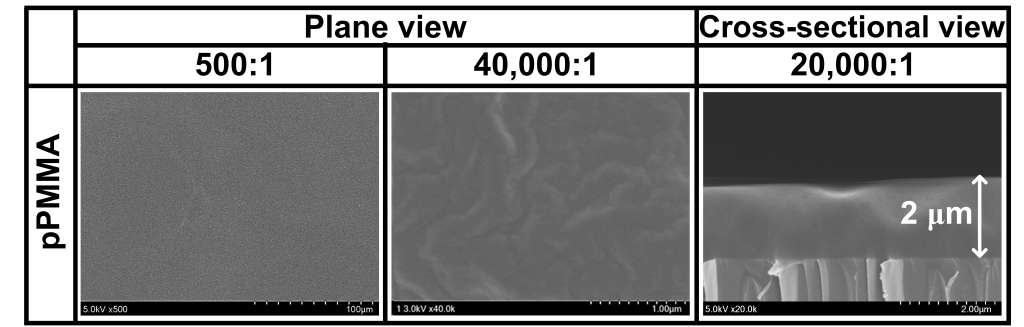
Figure 4. Plane and cross-sectional views of scanning electron microscopy (SEM) images of pPMMA thin films grown on a glass substrate when using the proposed APP polymerization technique after 90 min deposition.